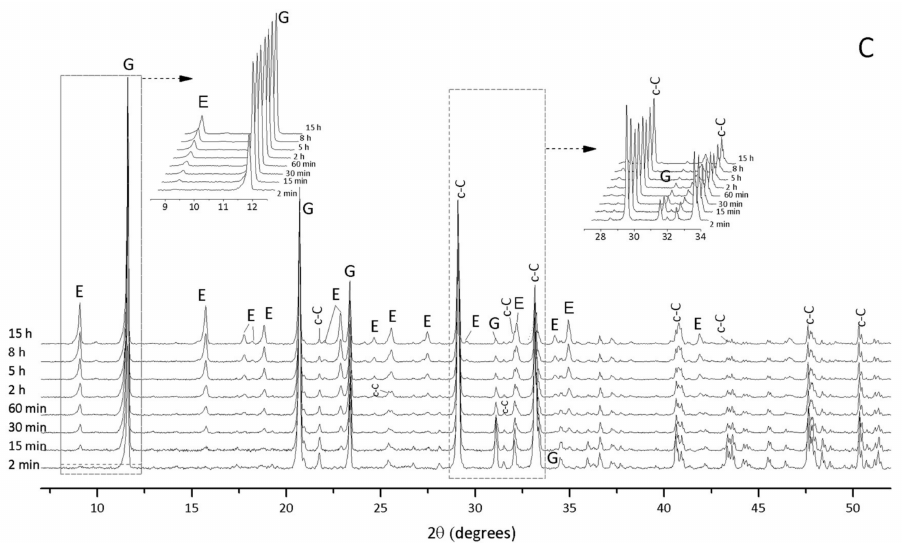
Figure 3. In situ XRD results of cub-C 3 A and gypsum hydration at gypsum/cub-C 3 A ratios of ( A ) 0.20; ( B ) 0.60; and ( C ) 1.90. c-C = cub-C 3 A, E = ettringite, G = gypsum, OH-AFm = C 4 AH 19